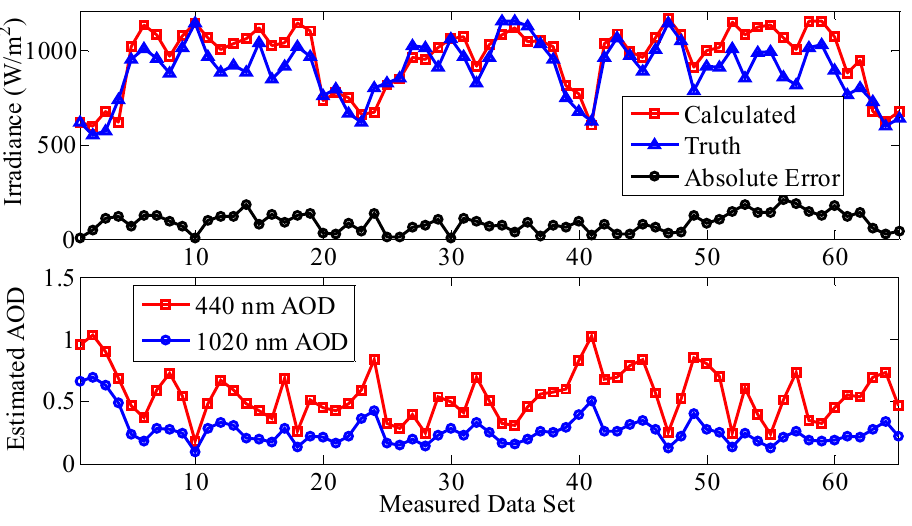
Figure 7. Calculation of accuracy evaluation of the simplified REST2 model.